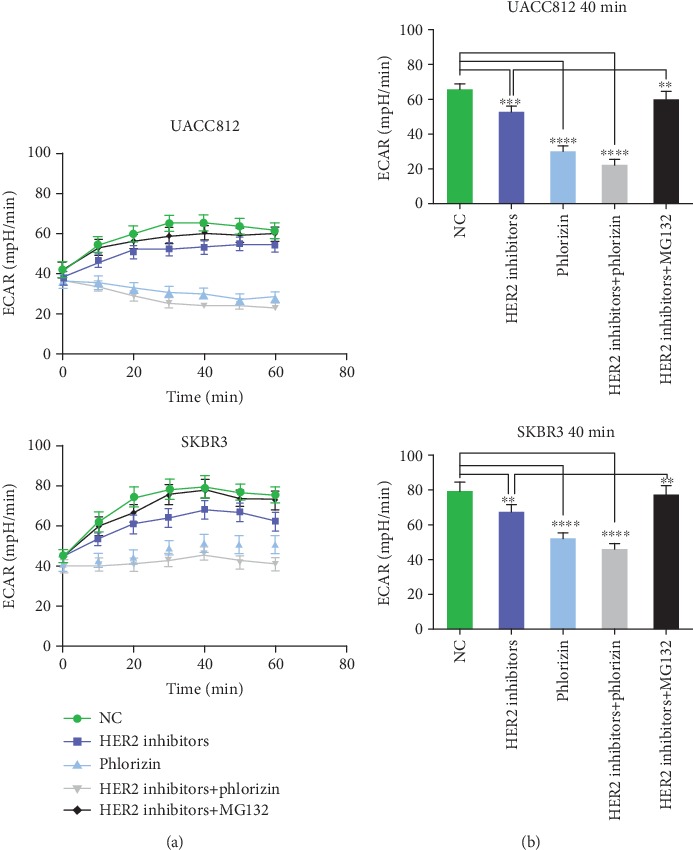
The curve and column results of the ECAR values for UACC812 and SKBR3 cells. (a) The ECAR values of UACC812 and SKBR3 cells treated with 0, 10, 20, 30, 40, 50, and 60 min, respectively. (b) The ECAR values of each group at 40 min in UACC812 and SKBR3 cells. Statistically significant differences between groups were displayed; ∗∗∗∗p < 0.0001; ∗∗∗p < 0.001; ∗∗p < 0.01.